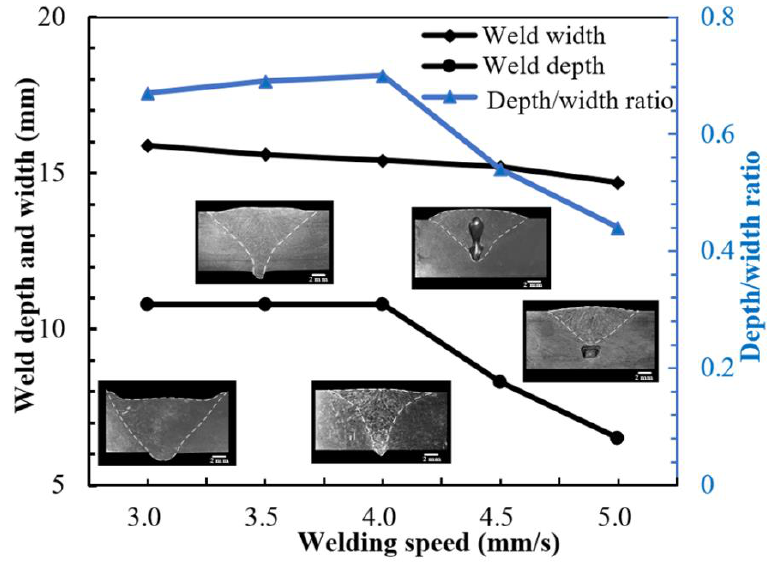
Figure 6. Geometry profile on the front of the S32101 duplex stainless-steel K-TIG welds.